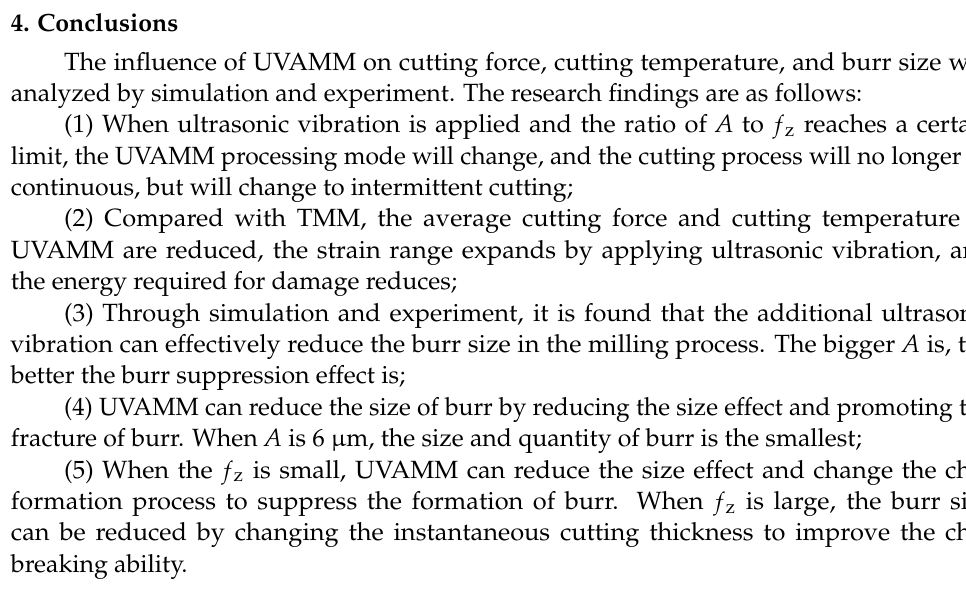
z (SEM); ( V c = 37.7 m/min, a p = 50 µ